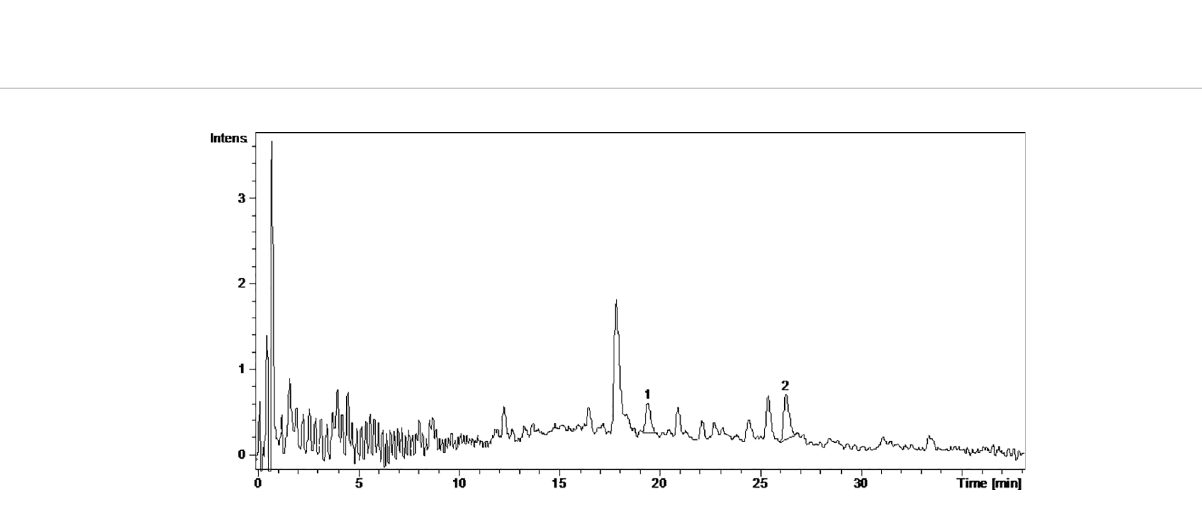
FIGURE 2 | The UV chromatogram of frtmented Pinot noir 2015 grape pomace extract. 1, Isoquercitrin; 2, Quercetin.